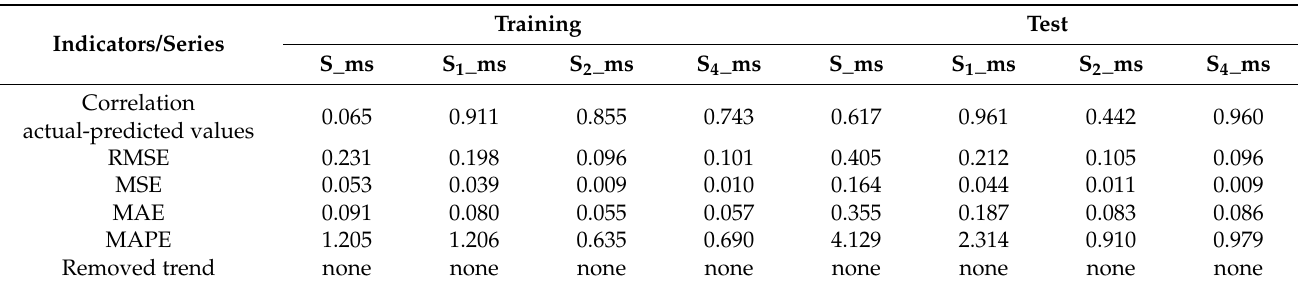
Table 10. Performances of the best models built for the deseasonalized monthly series its subseries with lag 1 variables as regressors.